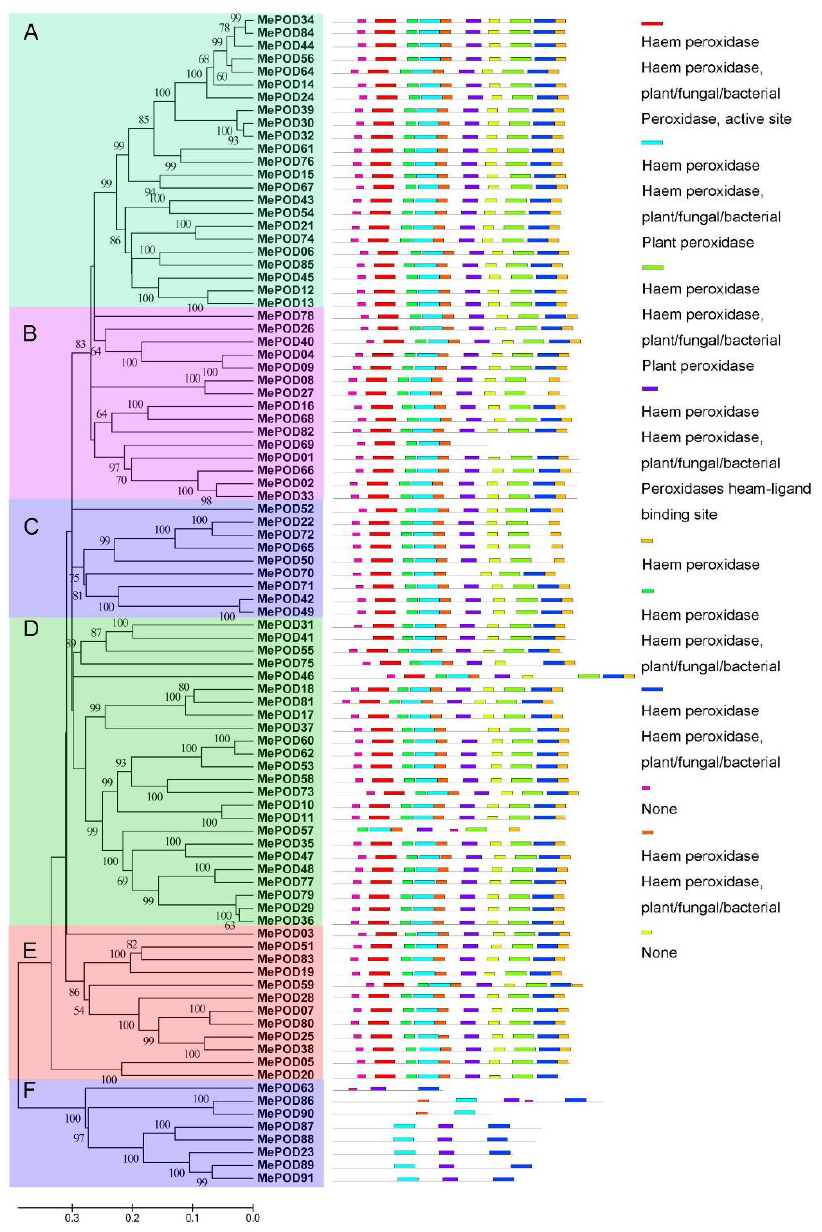
Figure 2. The motif analyses of POD family members in cassava according to their evolutionary relationship. The POD motifs were identified by the MEME database. The 10 different colors of the boxes on the right represent diverse conserved motifs, while the gray lines indicate non-conserved sequences.